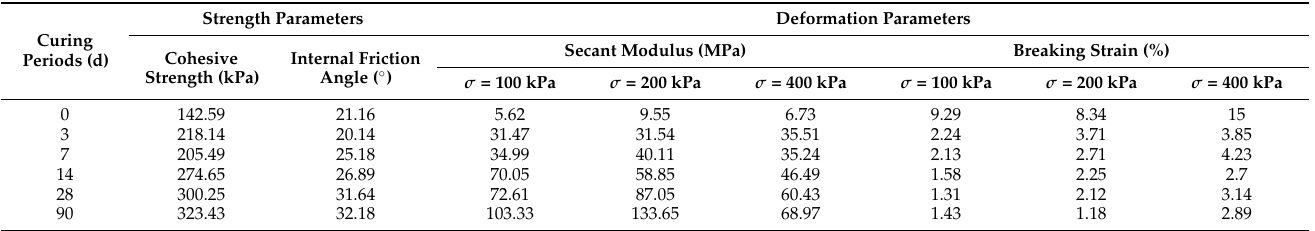
Table 6. Strength and deformation parameters of solidified/stabilized gold mine tailings after different curing